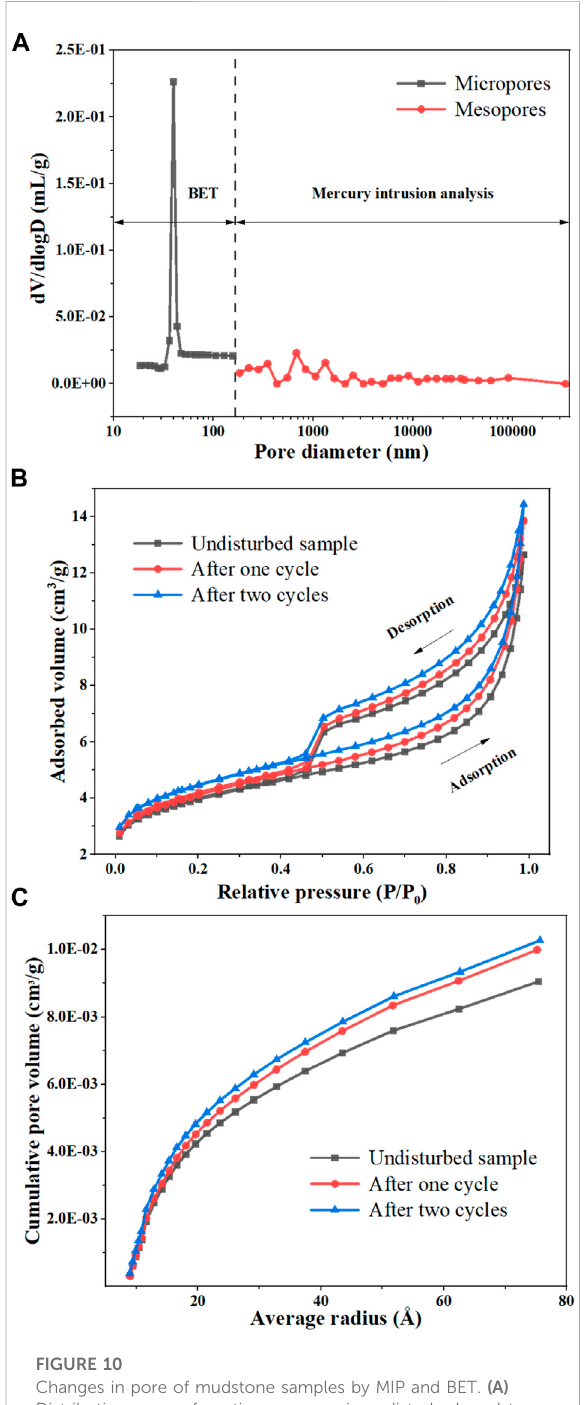
Changes in pore of mudstone samples by MIP and BET. (A) Distribution curve of continuous pores in undisturbed mudstone; (B) Isothermal adsorption curve under different cycles; and (C) Cumulative curve of pore